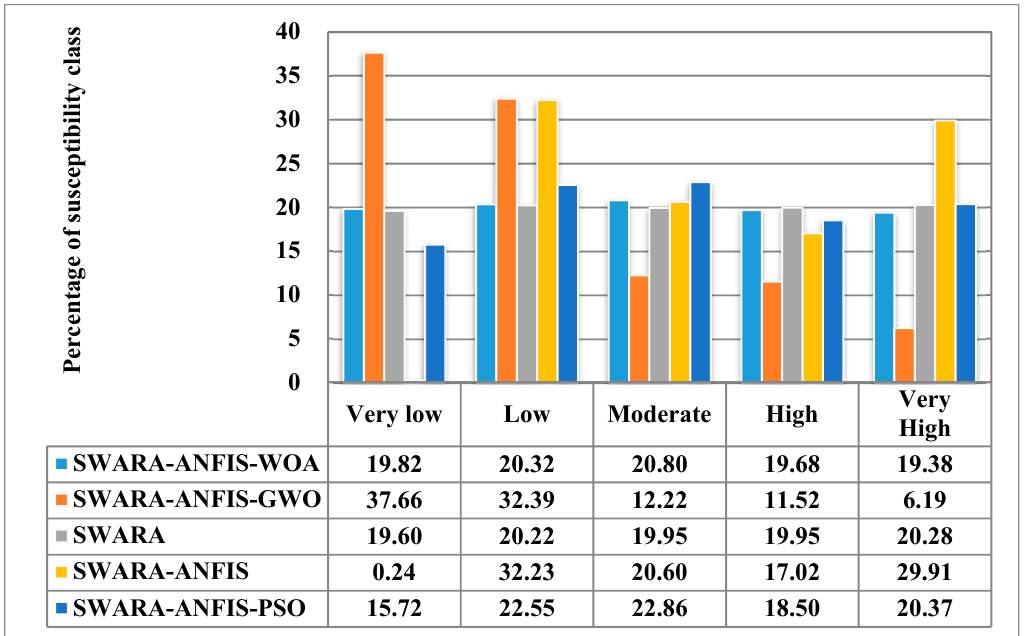
ff erent landslide susceptibility Figure 15. Percentages of different landslide susceptibility classes. Figure 15. Percentages of di Figure 15. Percentages of different landslide susceptibility classes.